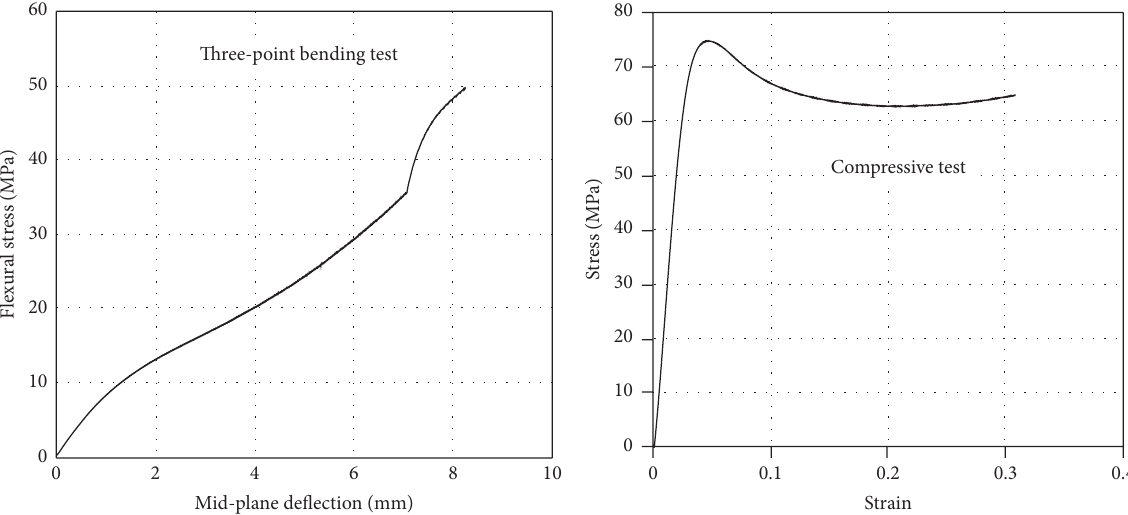
Figure 1: Mechanical response of cross linked epoxy polymer.